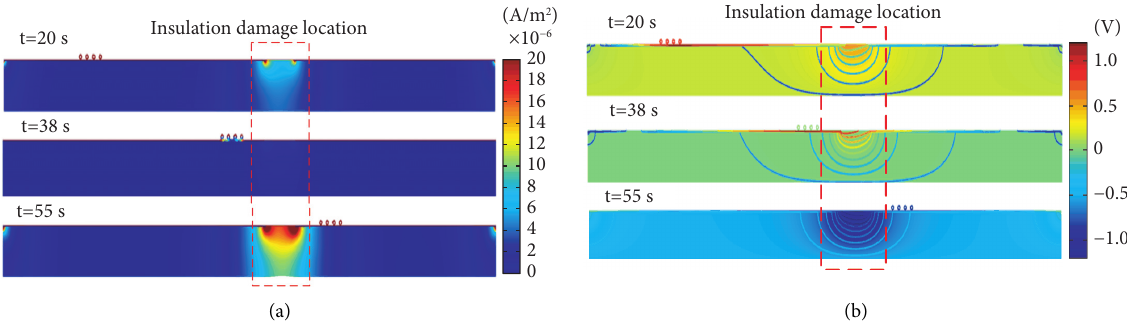
Figure 8: Distribution in soil at different times (when partial insulation is broken). (a) Current leakage. (b) Potential distribution.